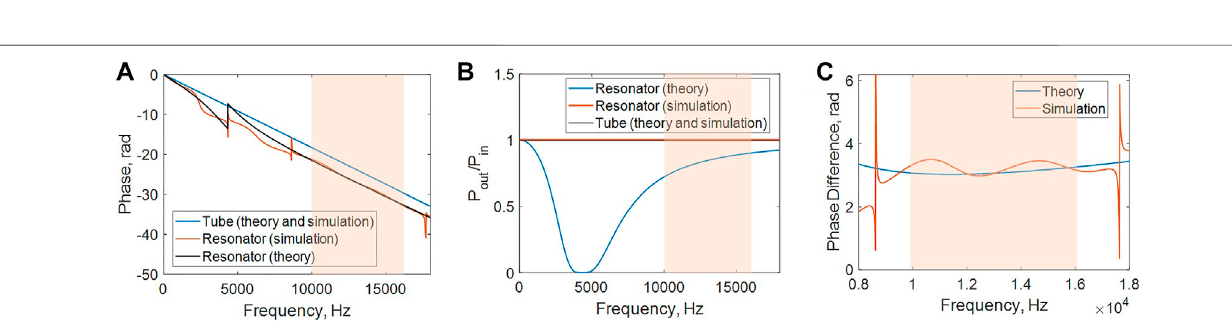
FIGURE 2 | Theoretical calculation and FEM simulation of the differential phase shifter with π phase difference. The orange shading marks the frequency range we choose to generate the π phase difference. (A) Theoretical and simulated phase response of the tube component (blue), theoretical phase response of the resonator component (black line), and simulated phase response of the resonator component (red line). (B) Theoretical and simulated amplitude responses of the tube and the resonator. (C) Theoretical and simulated phase difference between the two